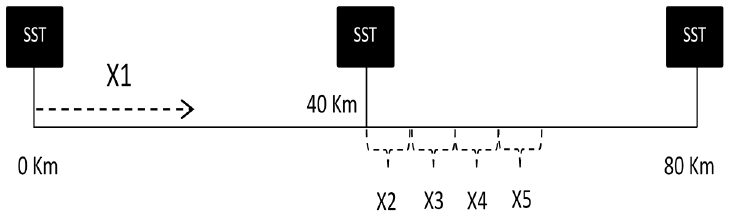
Figure 6. Position of the feeding substations (SST) along the test case line. The substation at 40 km is out of order. The variables X1 to X5 model the traffic adjustment actions (see Section 4.2.1). X1 is the increase of time between successive train departures, whereas X2 to X5 are speed reductions along different line segments.